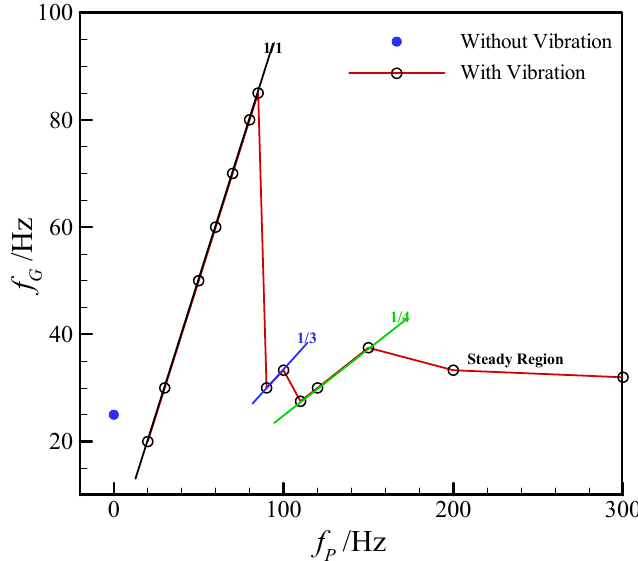
Figure 5. Variation of droplet generation frequency with external vibration frequency in the co-flowing microfluidic device, data are cited from reference [11].